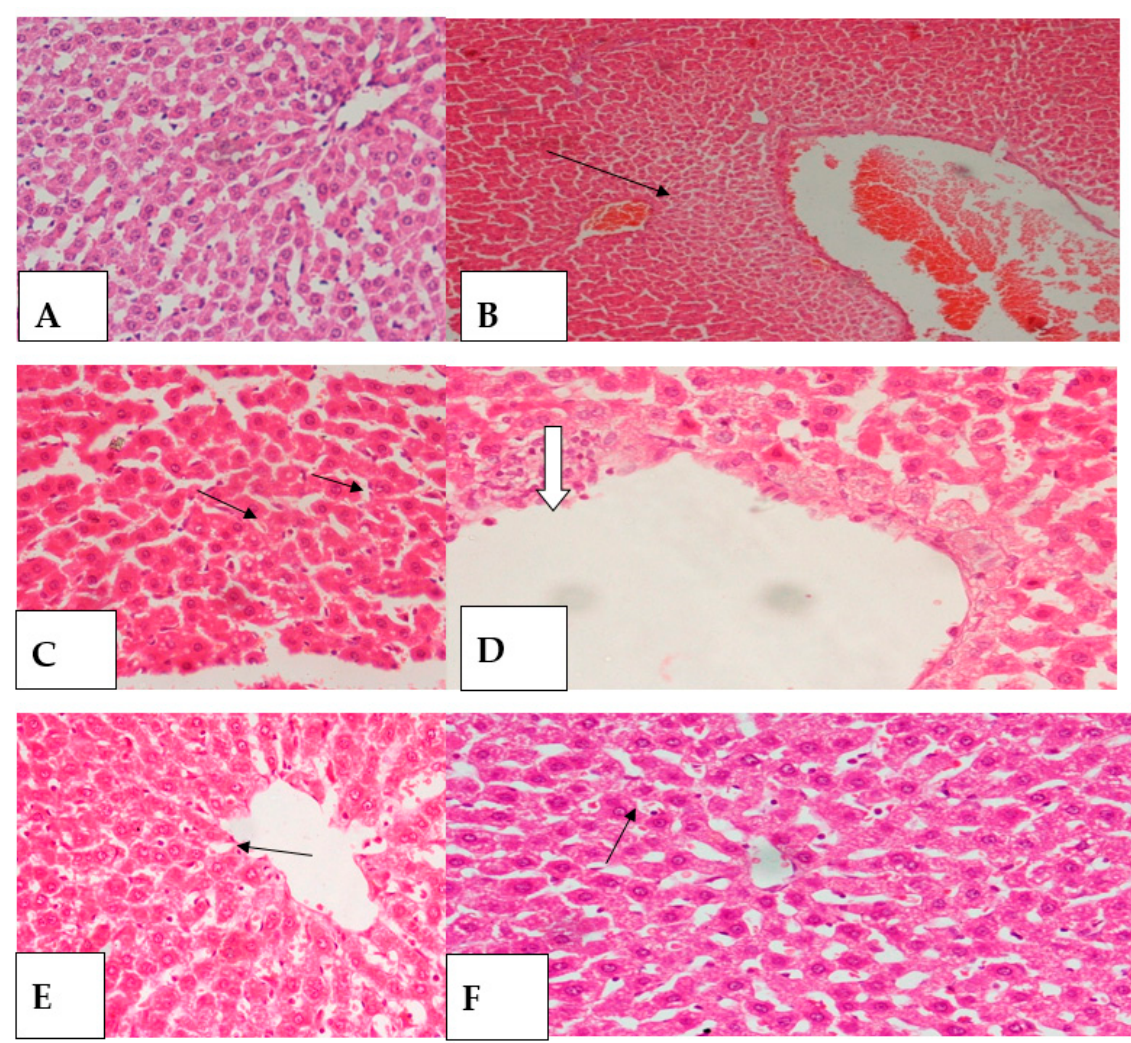
Figure 4. ( A ). Liver tissue of control rat showing preserved architecture with cords of linehepatocytes radiating from it with intervening sinusoids (H&E × 400). ( B ). Liver tissue of diabetic untreated rat showing marked dilatation and congestion of central vein (thin black arrow) (H&E × 100). ( C ). Liver tissue of diabetic untreated rat showing micro vesicular vacuolar degeneration (thin black arrows) within hepatocytes (H&E × 400). ( D ). Liver tissue of diabeticun treated rat showing widely dilated central vein, with perivascular fibrosis and aggregates of inflammatory cellsat periperhy (white arrow) (H&E × 400). ( E ). Liver tissue of diabetic rat treated with reference drug showing preserved architecture and ordinary hepatocytes; with residual, focal, mild micro vesicular degeneration (thin black arrow (H&E × 400). ( F ). Liver tissue of diabetic rat was treated with compound ( 4 ) showing marked improvement, preserved architecture and hepatocytes approximating ordinary ones; with residual, focal, very mild micro vesicular degeneration (thin black arrow) (H&E ×